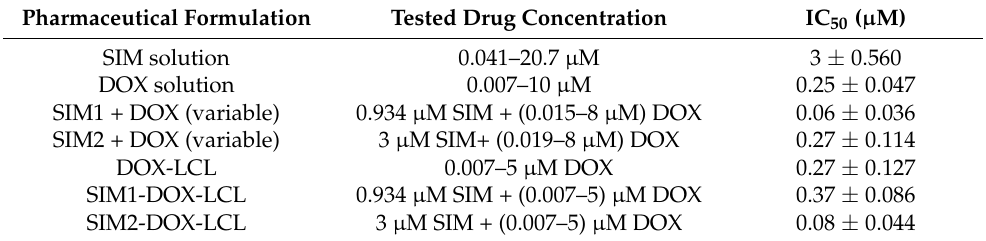
Table 6. Summary of IC 50 of SIM and DOX, administered as free or liposomal form. Pharmaceutical